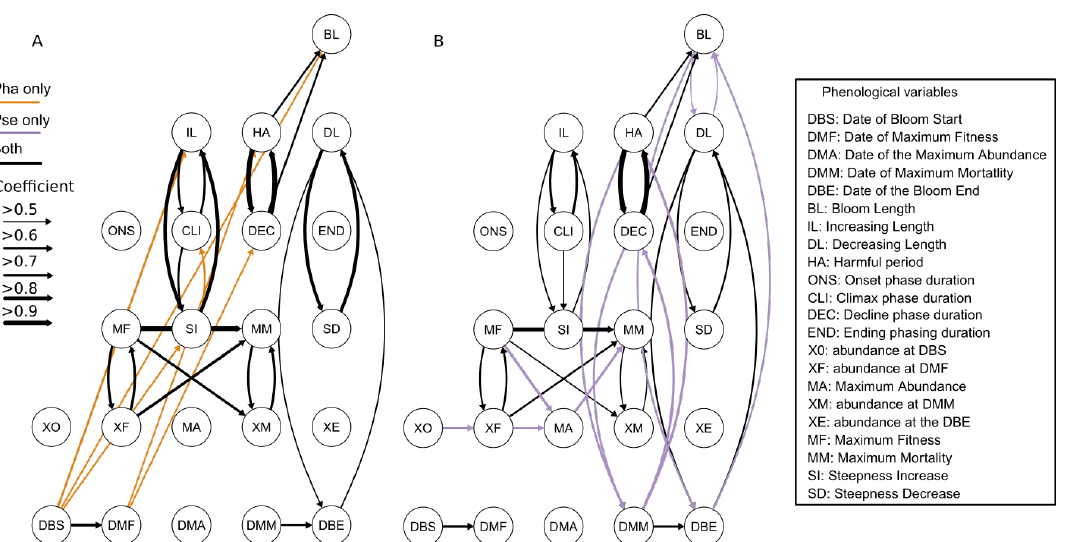
Figure 7. Summary of the pairwise qad relationship between the phenological variables characterizing the bloom of Phaeocystis sp. in ( A ), and of the complex Pseudo-nitzchia in ( B ). Only the significant ( p > 0.05) and a quantification of dependence >0.5 are shown. All coefficients with their respective significance can be found in the Figure